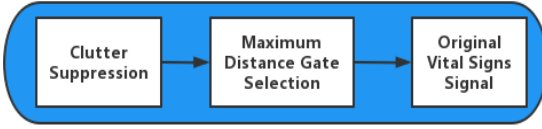
Figure 1. Schematic diagram of the radar echo signal.